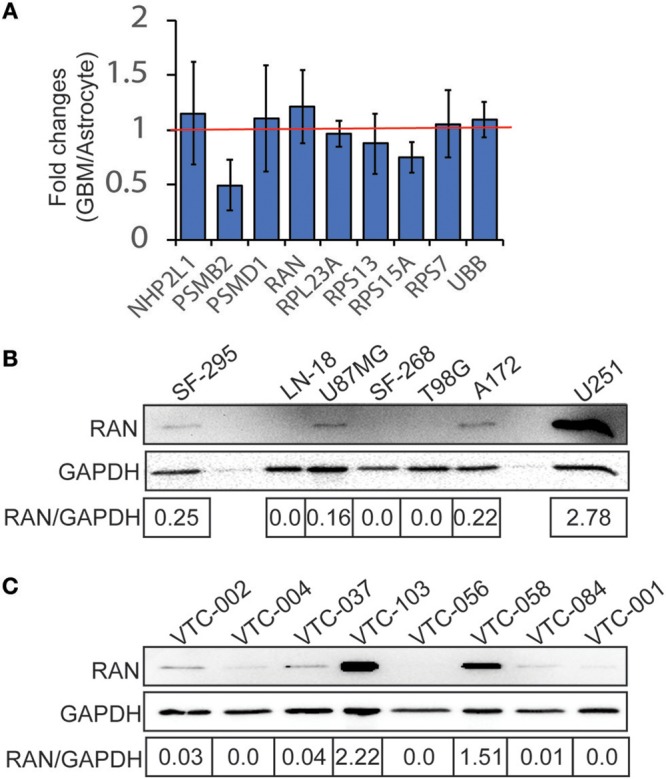
Expression of candidate genes in GBM. (A) cDNA microarray data were retrieved from the BioGPS database. The intensities of probes detecting candidate mRNAs in GBM cell lines were divided by those in astrocytes, yielding fold changes (GBM/Astrocyte). Fold changes of NHP2L1, PSMD1, RAN, RPS7, and UBB were above 1 (red line), suggesting that levels of these candidate mRNAs were high in GBM cell lines. Among these candidates, RAN levels in GBM are the highest. Error bars represent standard deviations from six GBM cell lines. (B) RAN protein levels in GBM cell lines. RAN and GAPDH proteins were detected in 7 GBM cell lines as indicated using immunoblotting. Band intensities were quantified using Image J. Fold changes (RAN/GAPDH) were obtained by dividing intensities of RAN with those of GAPDH. (C) RAN protein levels in primary GBM cells.